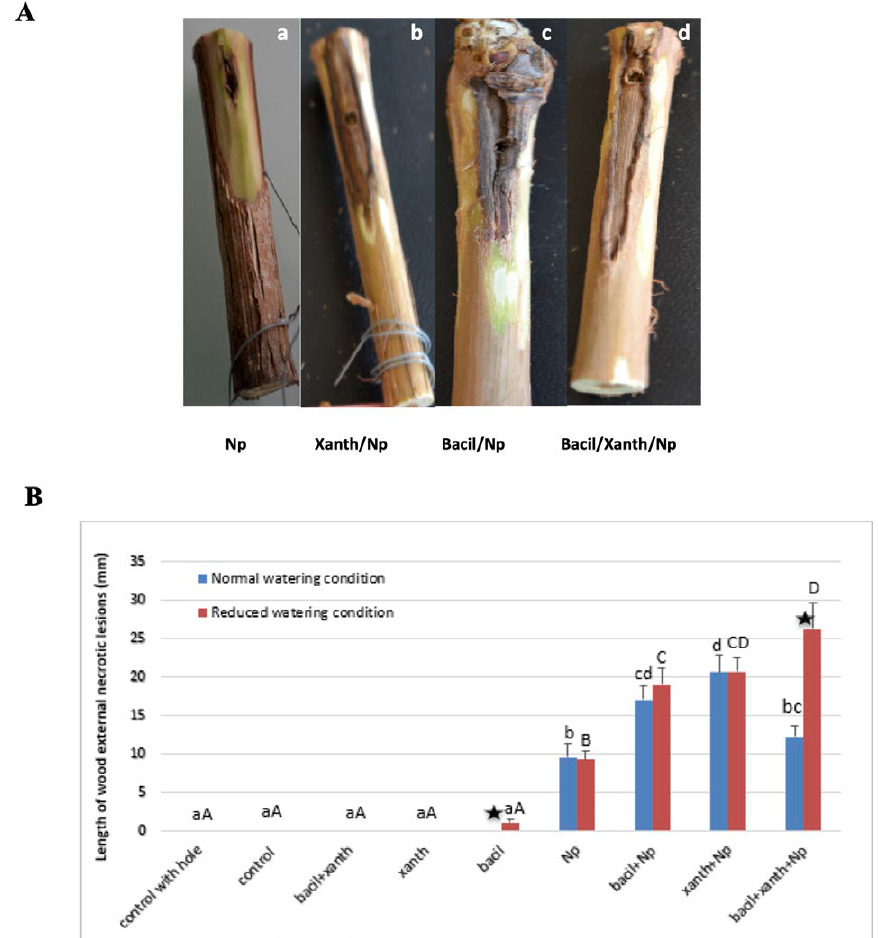
Figure 3. A. Mean wood canker lesion lengths on grapevine cuttings. (a) cuttings inoculated with Neofusicoccum parvum only; (b) cuttings co-inoculated with N. parvum and Xanthomonas sp. (S45); (c) cuttings co-inoculated with N. parvum and B. pumilus (S35); (d) cuttings co- inoculated with N. parvum and Xanthomonas sp. (S45) and B. pumilus (S35). B. Mean (±SE) wood canker lesion lengths from the different treatments in the second bioassay, under two water conditions, 9 months post-inoculation. Each value is the mean of 30 cuttings. Means accompanied by the same letter are not different ( P < 0.05; Kruskal-Wallis test. indicates statistically significant interactions for the same modality under the two water